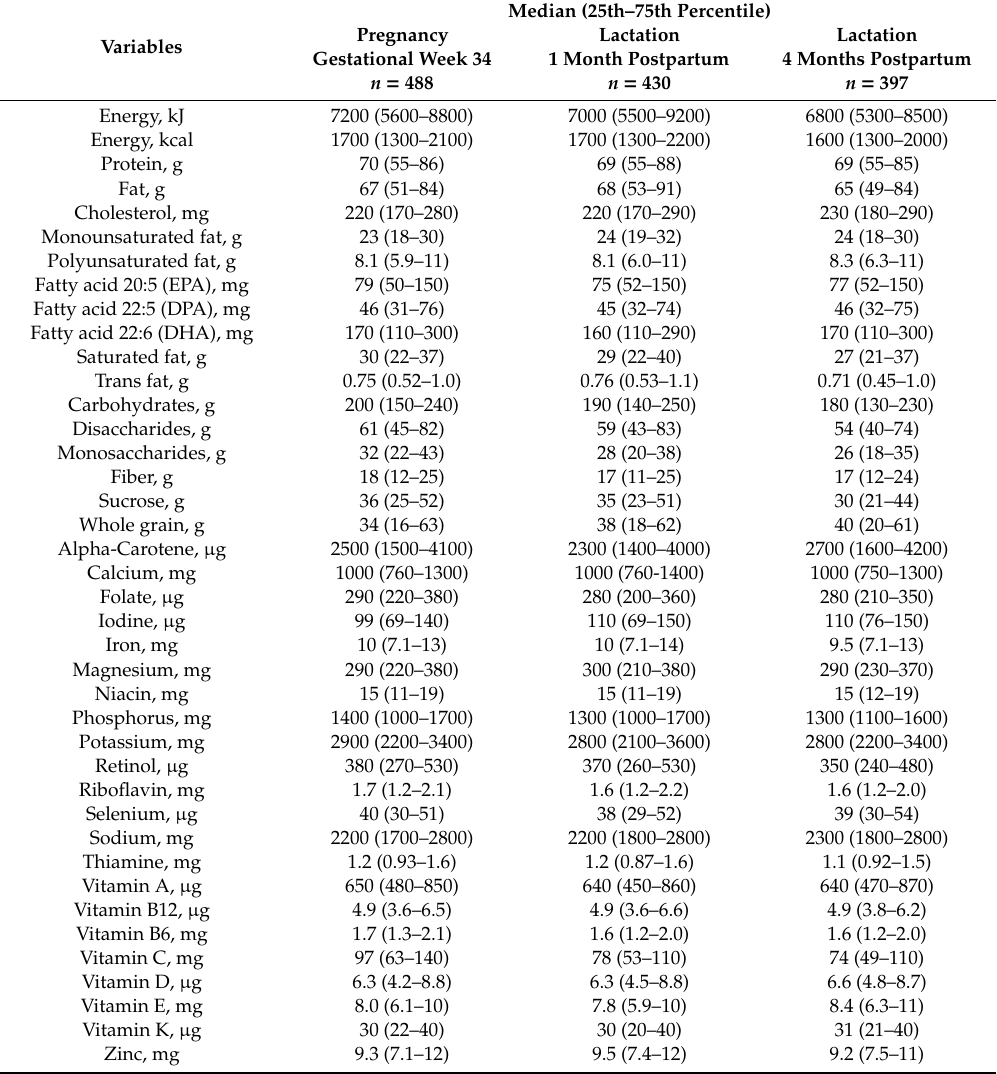
Table 3. Dietary intake levels of nutrients during pregnancy and